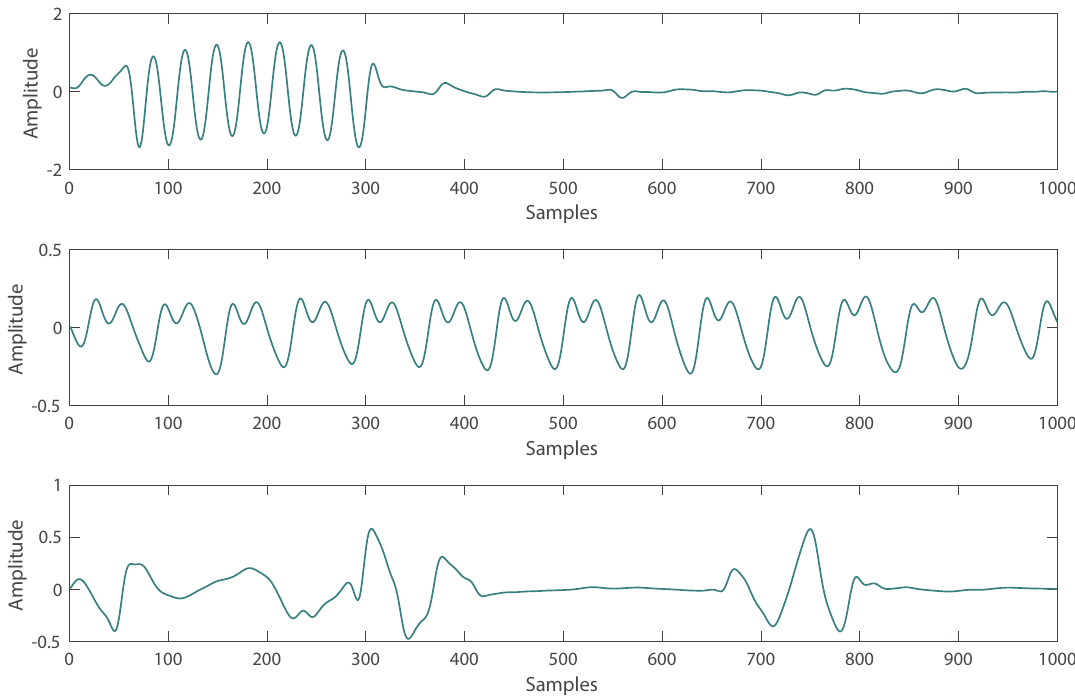
Figure 1. Abnormal PPG signals with irregular waveform.